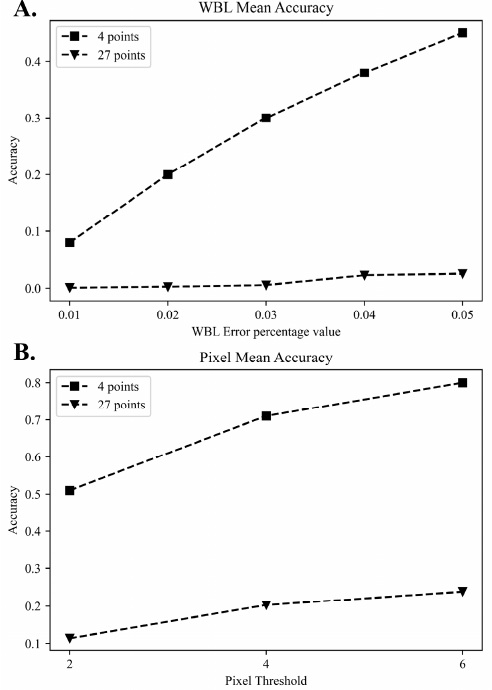
Figure 2. Comparison of WBL mean accuracy in 4 and 27 points. ( A ) Comparison graph of 4 and 27 points in WBL error percentage. ( B ) Comparison graph of 4 and 27 points in pixel threshold. Validation set: the data sample used to provide an unbiased evaluation of a model fit on the training dataset while tuning the model hyperparameters. Test set: the data sample used to provide an unbiased evaluation of a final model fit on the training dataset.